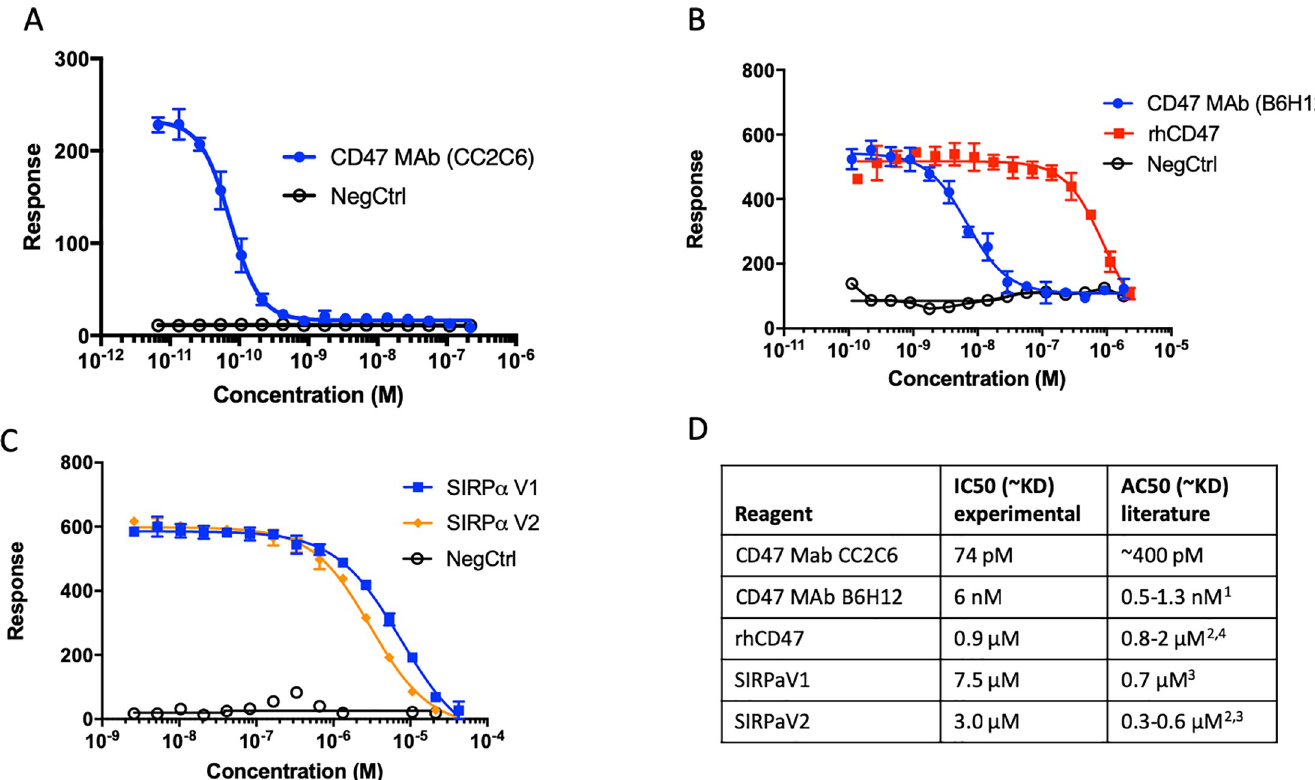
Fig 4. LSC-based ligand binding activities agree with previous biochemical studies. SIRP α binding to CD47(+) cells was inhibited using a fixed SIRP α concentration (20 nM) and a titration of the anti-CD47 monoclonal antibody clone (A) CC2C6, (B) B6H12, or recombinant human CD47 (rhCD47) or (C) non-biotin conjugated (cold) SIRP α V1 and V2. Negative control indicates background nonspecific binding (-SIRP α ). Error bars indicate standard deviation of n = 4 replicates. (D) The IC50 value for each reagent competing with SIRP α for binding CD47 on Jurkat cells and their comparison to their literature derived biochemical affinities. 1 [28]; 2 [42]; 3 [38]; 4